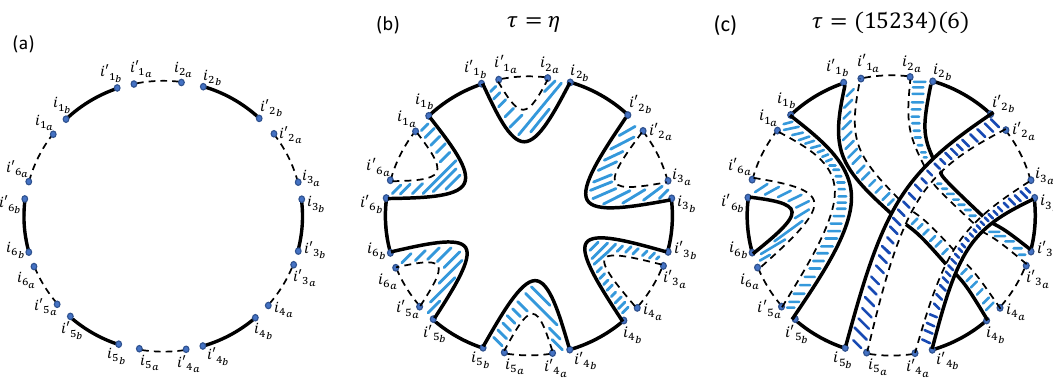
( A ) n ( ⌧ ), coming from the factor in parentheses in Z , ⌧ . |I ↵ i